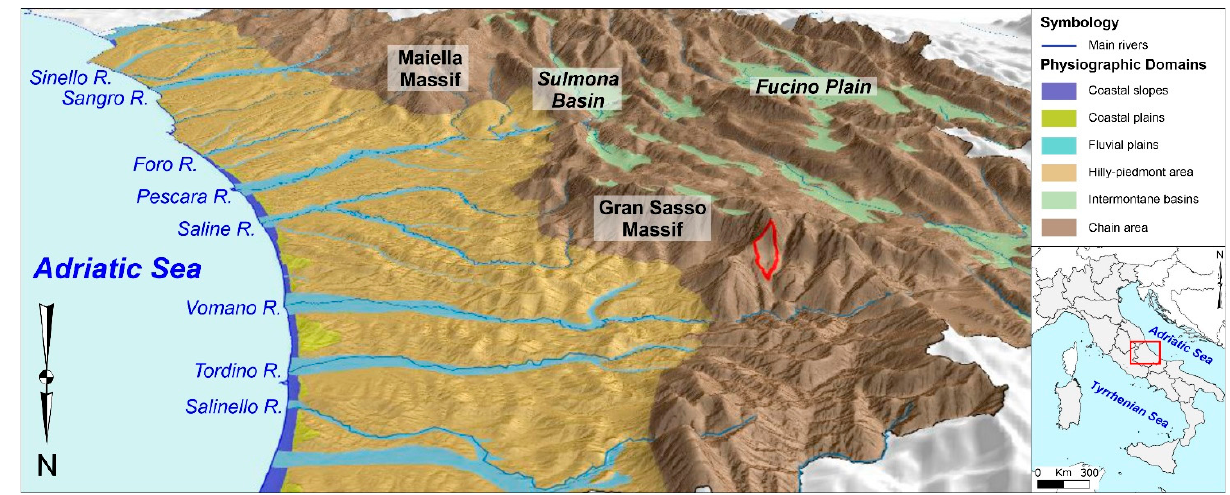
Figure 1. Three-dimensional view (from 20 m DTM, SINAnet) of the Abruzzo Region (Central Italy) and main physiographic domains. The red polygon indicates the study area.